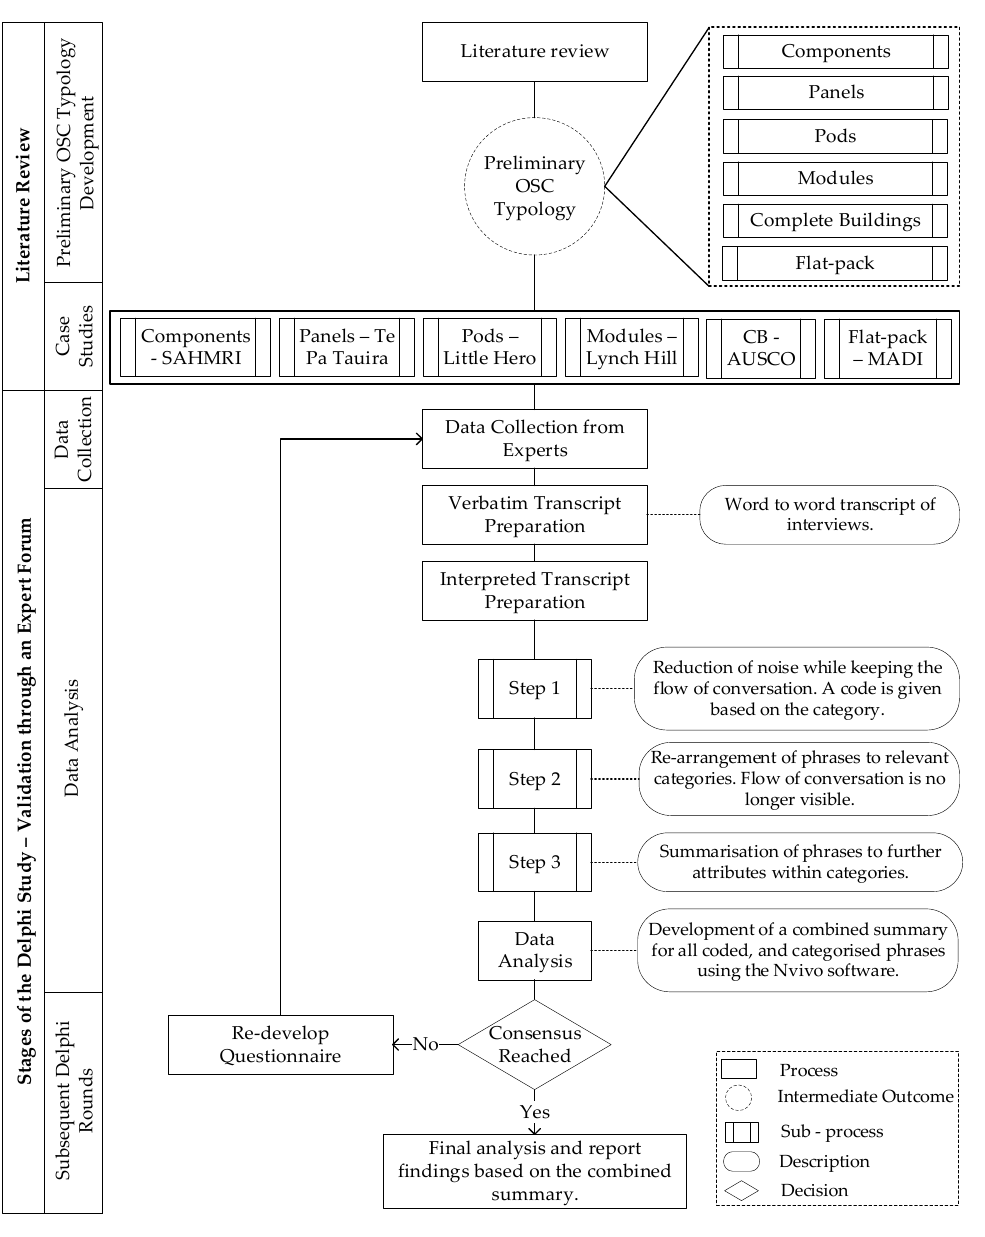
Figure 2. Research methodology flowchart.